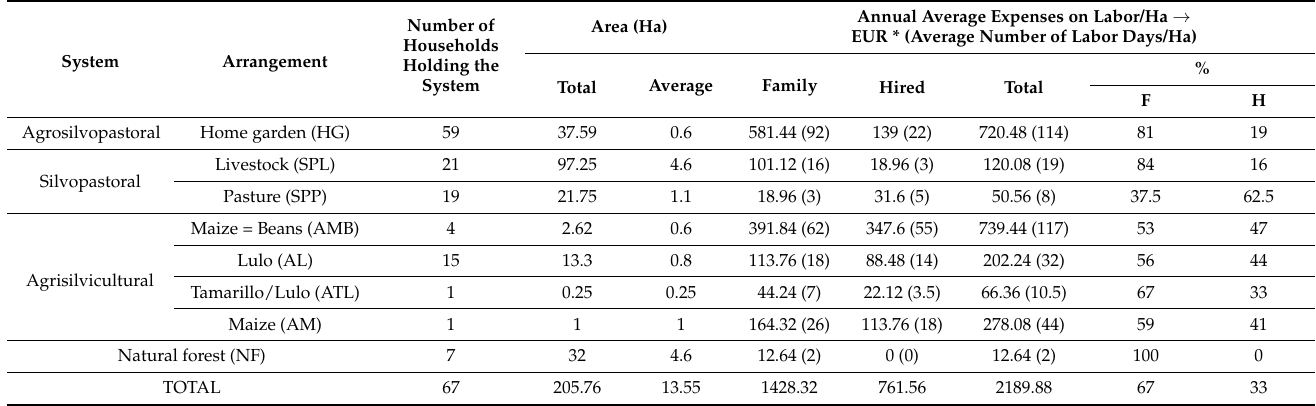
Table 2. The number of households holding the arrangements, total and average area, annual average expenses on family labor, annual average number of labor days spent, and percentage of family versus hired labor of the agroforestry systems in the Sibundoy